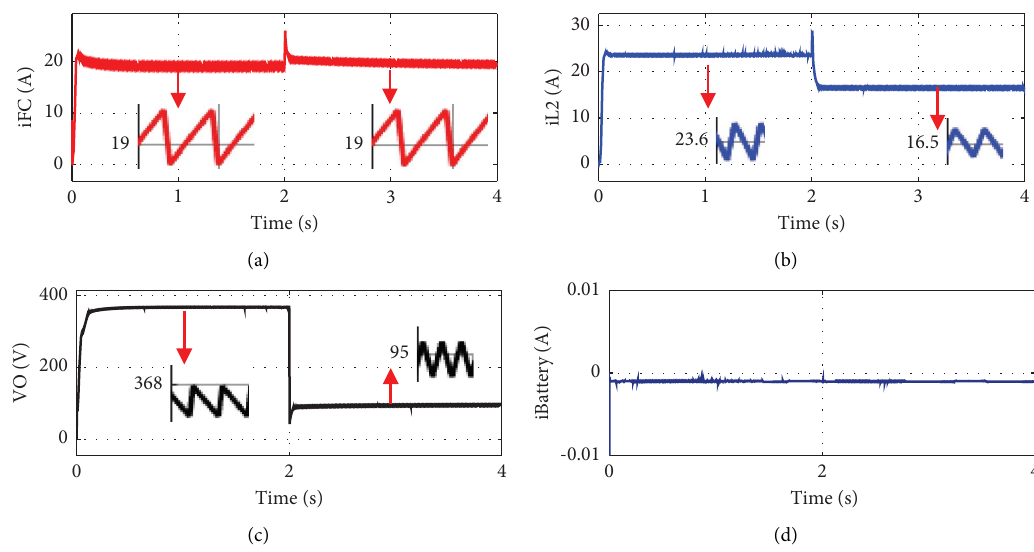
Figure 17: DC-DC converter specifcations. (a) Current of FC, (b) current of iL2, (c) output voltage, and (d) current of